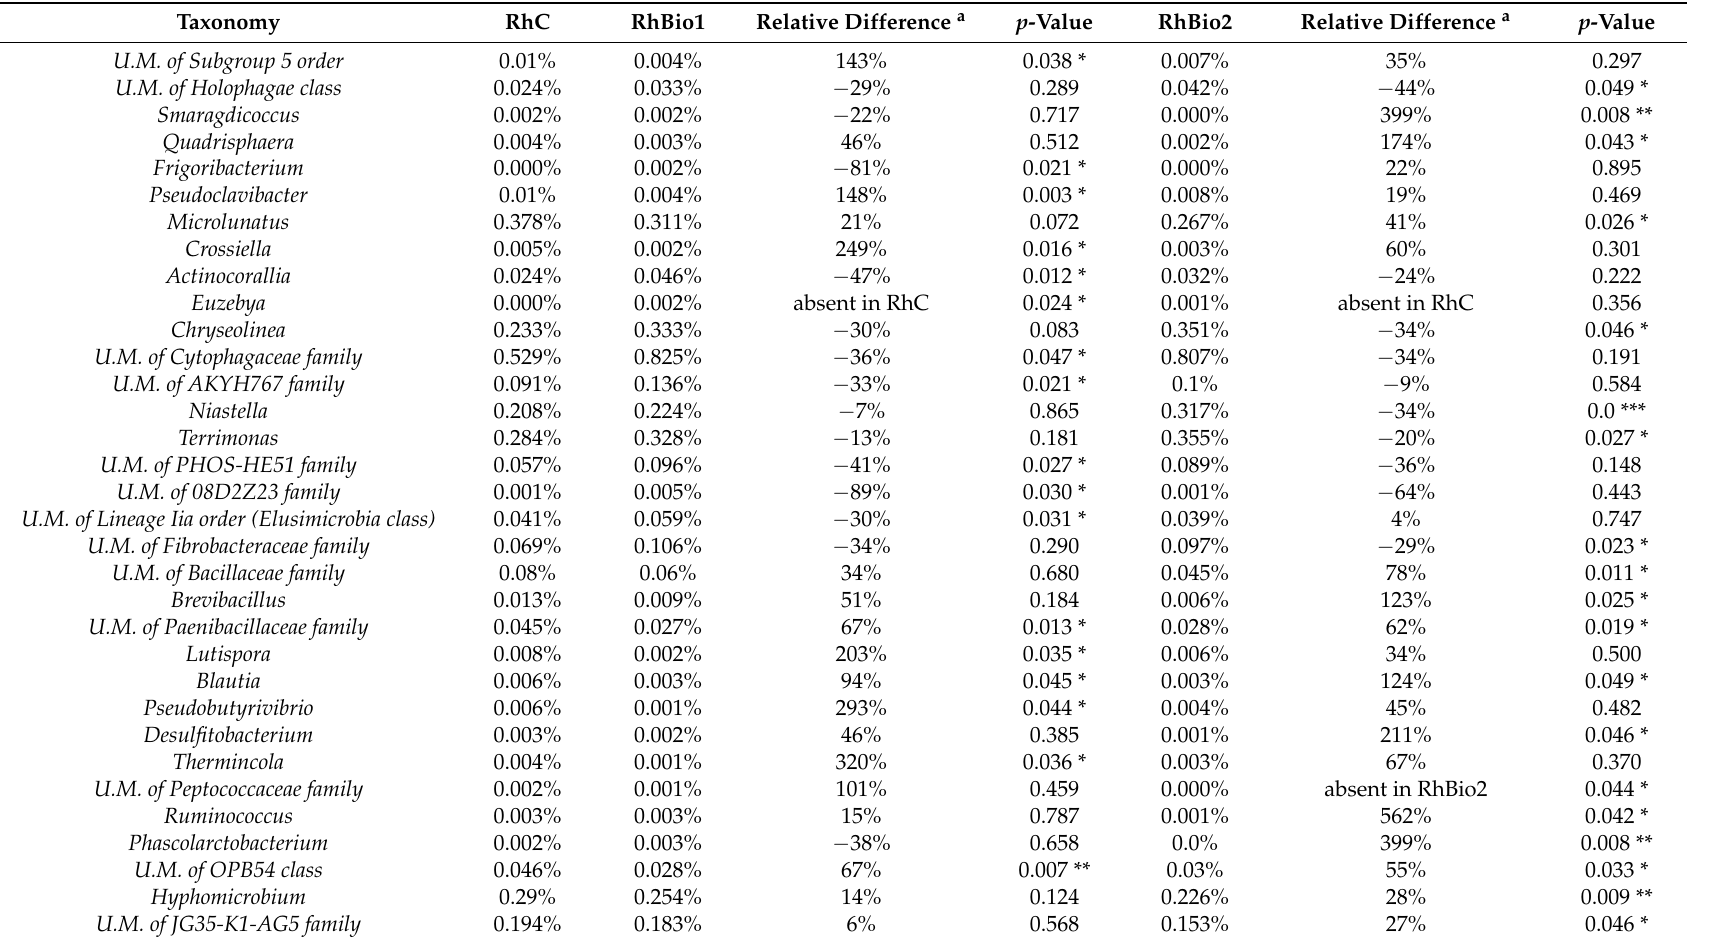
Table 2. The bacterial taxa present at the Chivasso site with at least one significant variation ( p -value ≤ 0.05) in the rhizospheres of maize plants grown from seeds treated with Bio1 and Bio2 compared with untreated controls. Data reported are presented as the percentages of the abundance of the mean values of 4 biological